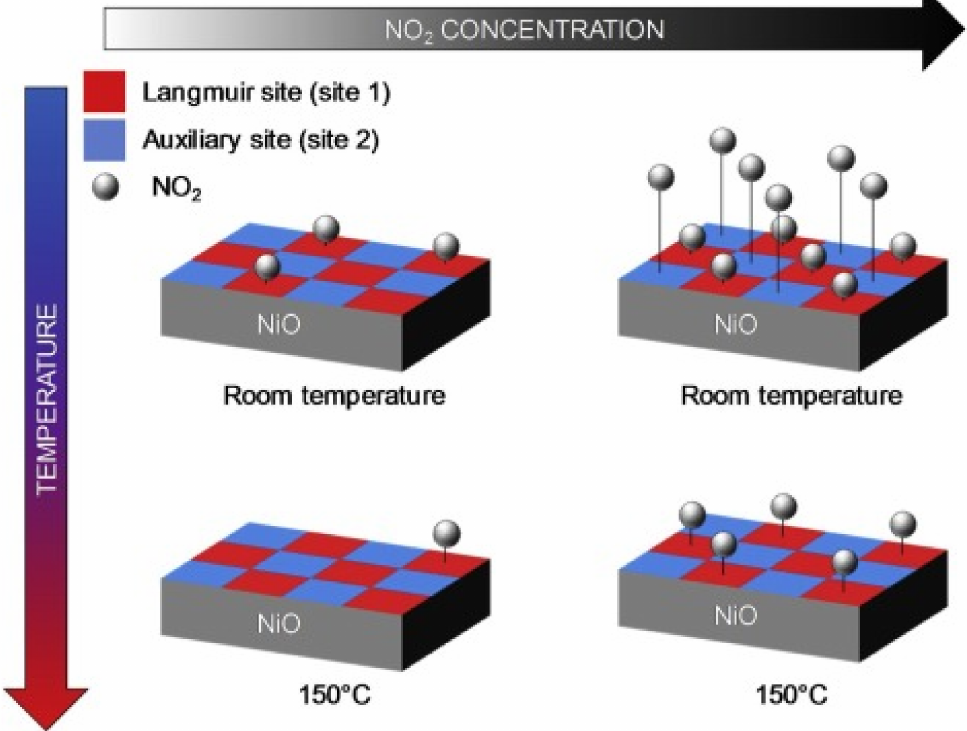
Figure 19. Schematic illustration of the proposed model for NO 2 detection by the nanoporous NiO film as a function of temperature and NO 2 concentration. Reprinted with permission from